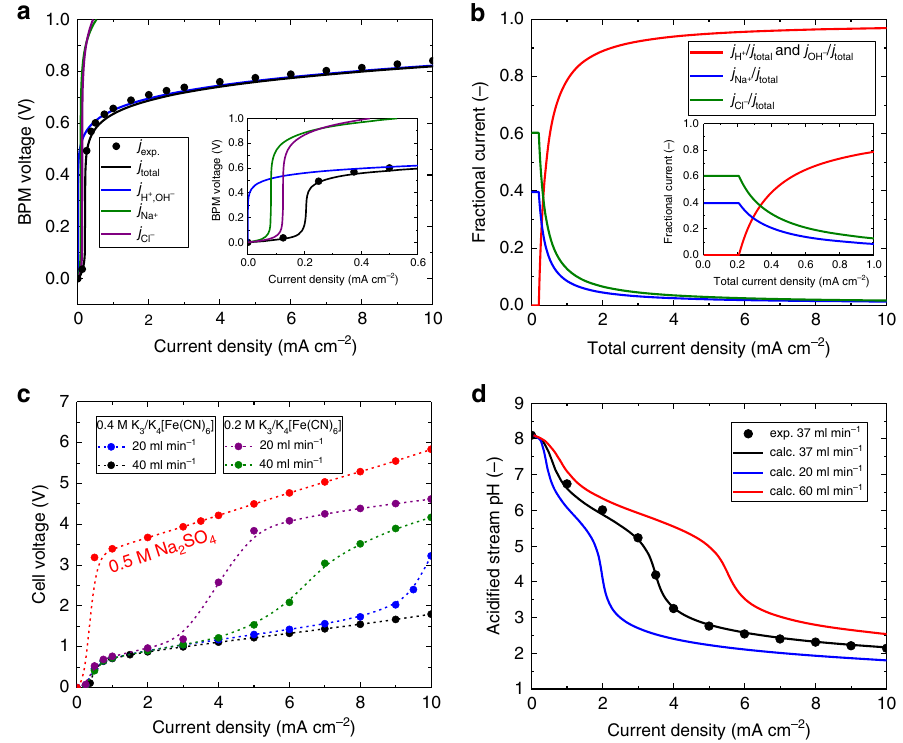
Fig. 2 BPM electrodialysis performance characteristics. a Simulated BPM voltage vs. total current density (black line) as well as partial current density carried by major ions, including proton and hydroxide for water dissociation (blue line), Na + (green line) and Cl − (purple line), in the synthetic oceanwater. Black dots indicate the experimentally measured BPM voltage as a function of the applied current density, corrected for the ohmic resistance in the (cid:4) (cid:5) (cid:4) (cid:5) (cid:4) (cid:5) (cid:4) (cid:5) oceanwater. b Fractional current carried by H + j H þ = j total , OH − j OH (cid:2) = j total , Na + j Na þ = j total and Cl − j Cl (cid:2) = j total across the BPM as a function of the total current density ( j total ). c Experimentally measured voltage-current density characteristics of the BPM electrodialysis cell using 0.5 M Na 2 SO 4 electrode solution at a fl ow rate of 40 ml min − 1 (red dots), 0.4 M K 3 /K 4 [Fe(CN) 6 ] at a fl ow rate of 40 ml min − 1 (black dots) and 20 ml min − 1 (blue dots), 0.2 M K 3 / K 4 [Fe(CN) 6 ] at a fl ow rate of 40 ml min − 1 (green dots) and 20 ml min − 1 (purple dots). Dashed lines are used to guide the eye. d Experimentally measured (black dots) and calculated (lines) pH of the acidi fi ed stream as a function of applied current density for BPM electrodialysis cell with an electrode and membrane active area of 64 cm 2